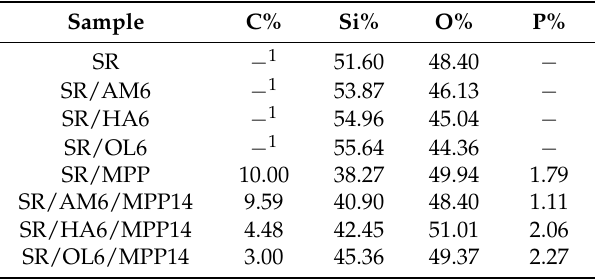
Table 7. EDS results residue after